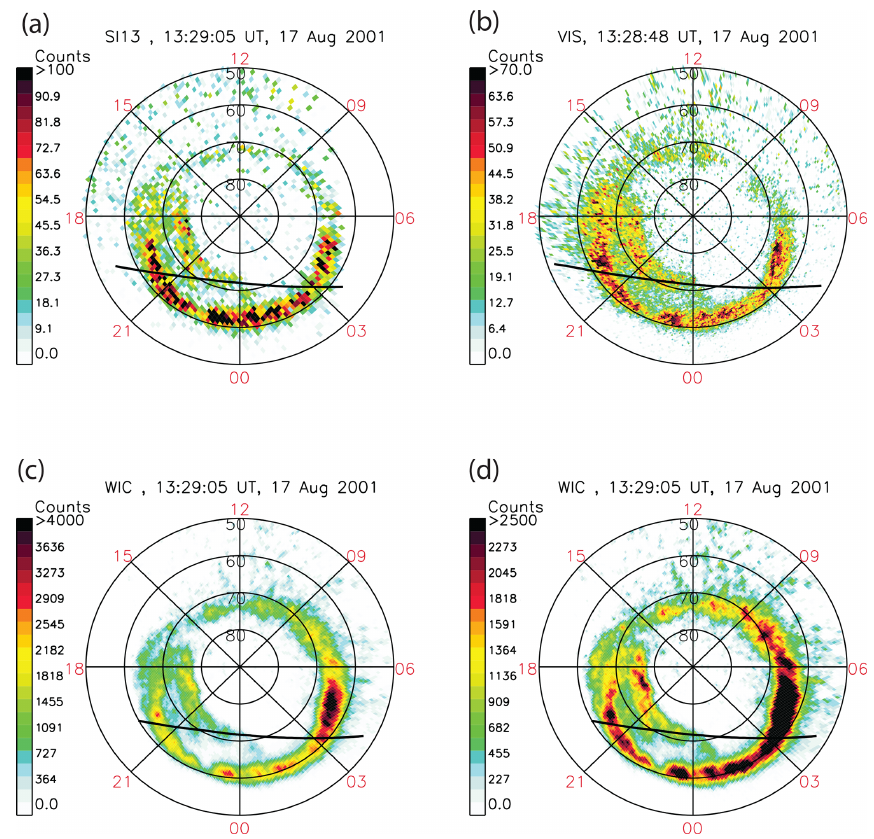
Figure 1. Images of different emission bands at 13:29UT, 17 August 2001, separated by ∼ 15s (center time). All images are from the Northern Hemisphere. Black lines indicate the terminator at 90 ◦ solar zenith angle. (a) IMAGE SI13; (b) Polar VIS; (c) IMAGE WIC, where the dawn aurora is scaled to match VIS; (d) IMAGE WIC, where the dusk aurora is scaled to match